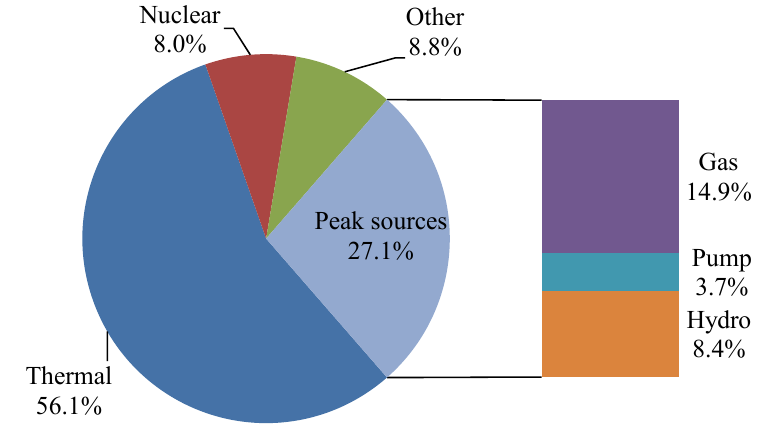
Figure 2. Installed capacity structure of Zhejiang power grid by the end of 2015.